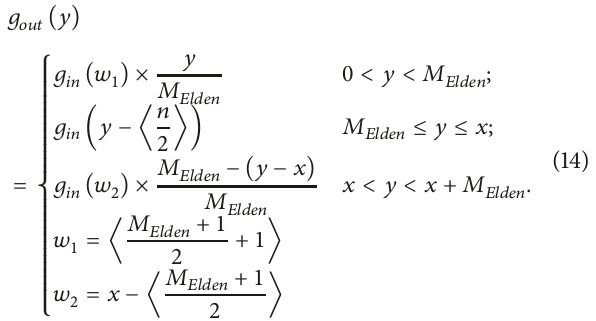
from 𝑔 1 to 𝑔 𝑞−1 and 𝑔 𝑝+1 to 𝑔 𝑝+𝑞−1 . The